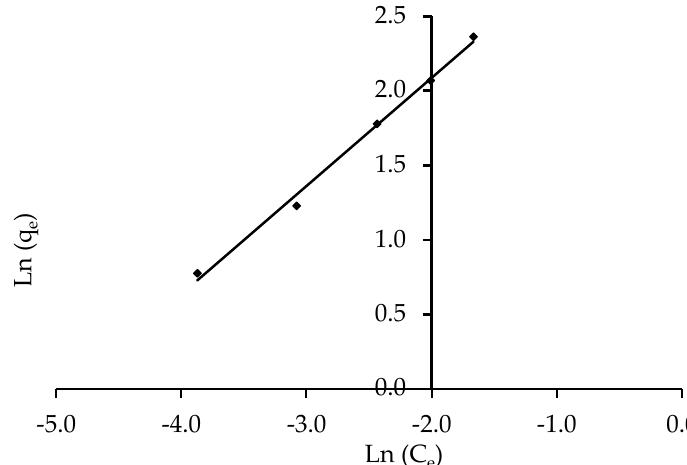
Figure 12. Halsey isotherm of the removal of IV2R by ZnO ‐ NPs.